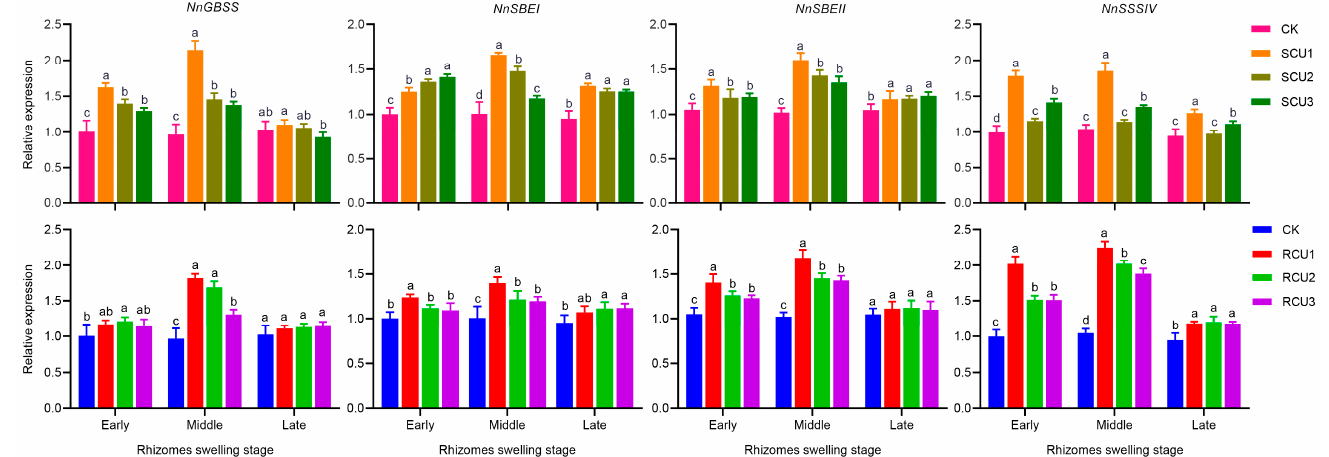
Figure 6. The relative expression level of starch biosynthesis enzyme genes under SCU and RCU treatments. Different letters indicate a significant difference in relative expression levels of starch biosynthesis enzyme genes at the swelling stage of the lotus rhizome between different treatments at the 5% level. Error bars show SD from three biological replicates.